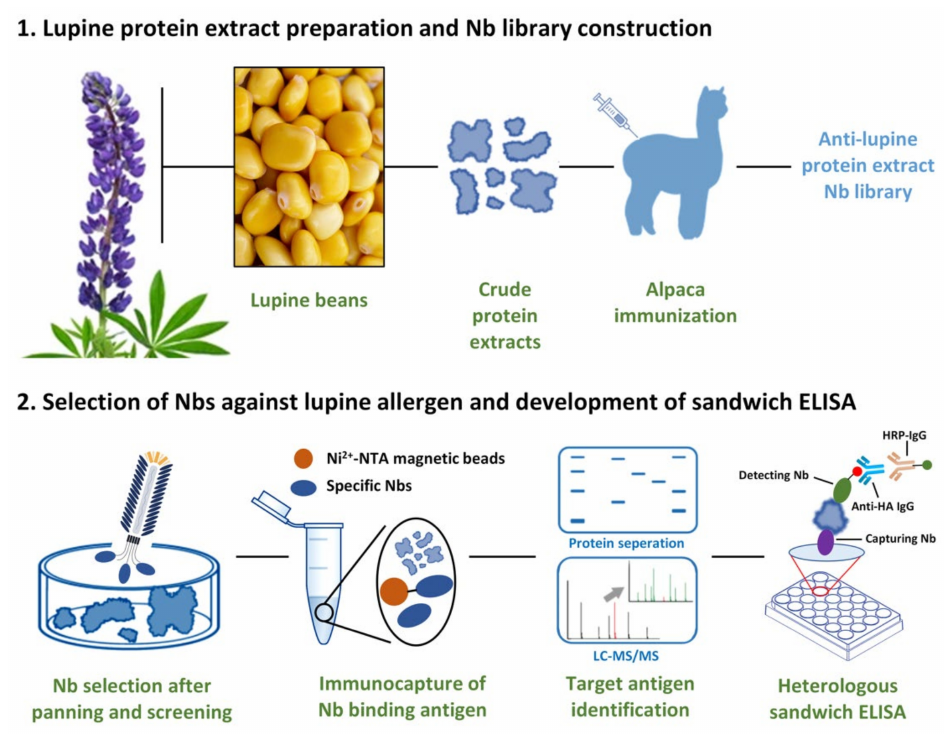
Figure 1. Illustration for the selection of specific Nbs with specificity against Lup an 1, and develop- ment of an